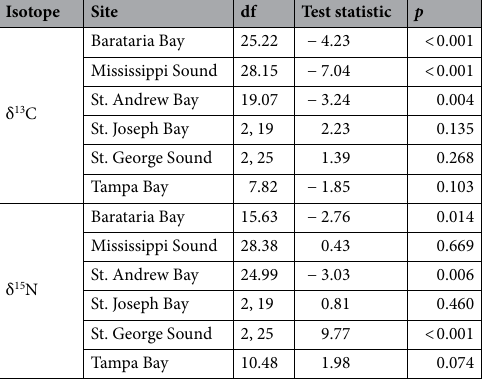
Table 3. Welch’s t test and ANOVA statistics for within site comparisons. T tests were performed when there were two locations per site and ANOVAs when there were more than two locations per site.